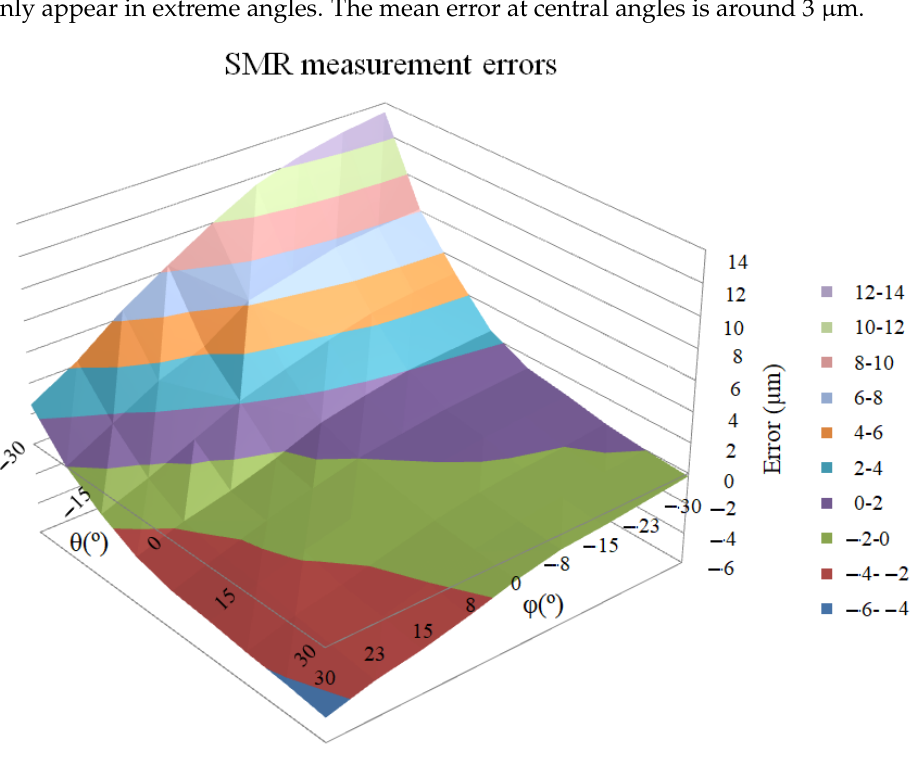
Figure 9. SMR measurement errors (µm) depending on the incidence angle (°).